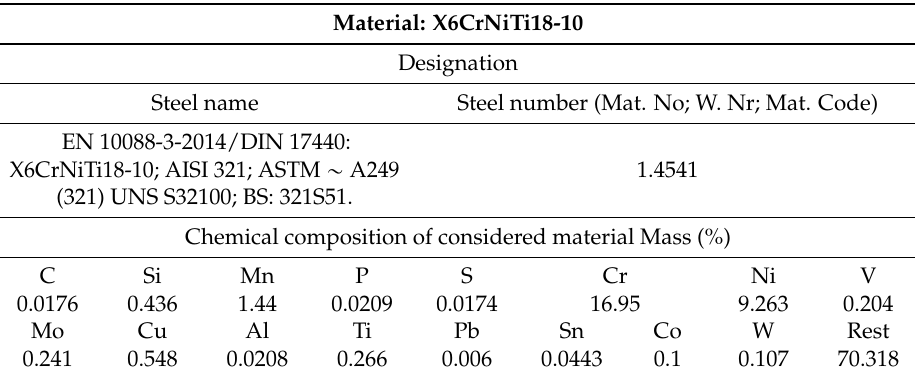
Table 1. Material chemical composition: X6CrNiTi18-10